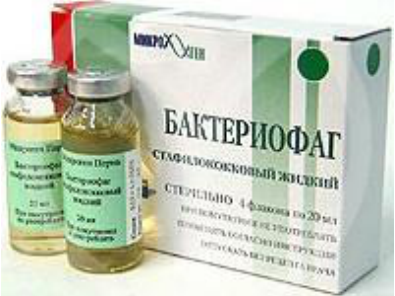
Figure 3. Sextaphage pharmaceutical product from microgen. Image reproduced with permission form reference [104] .